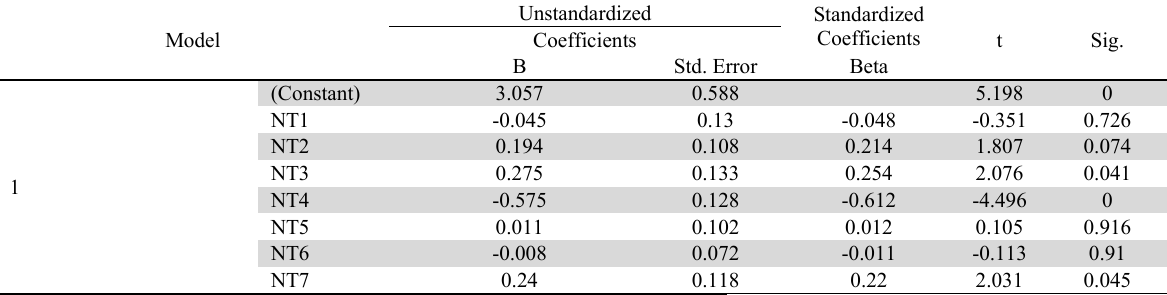
Regression analysis of factors affecting ROA Model